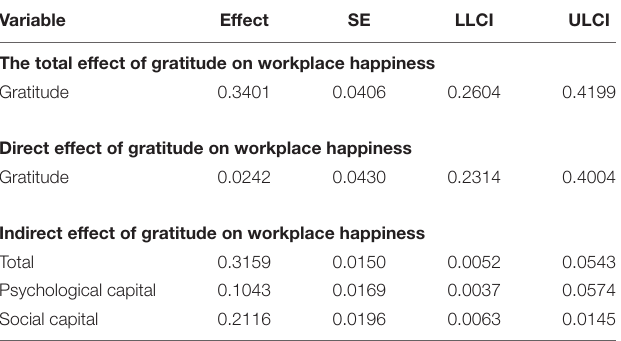
TABLE 4 | Effect size of necessary condition. TABLE 5 | Results of parallel multiple